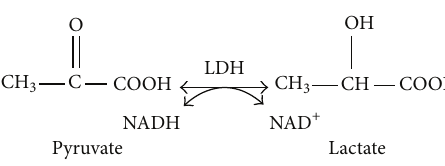
Figure 1: Generation of NAD + from